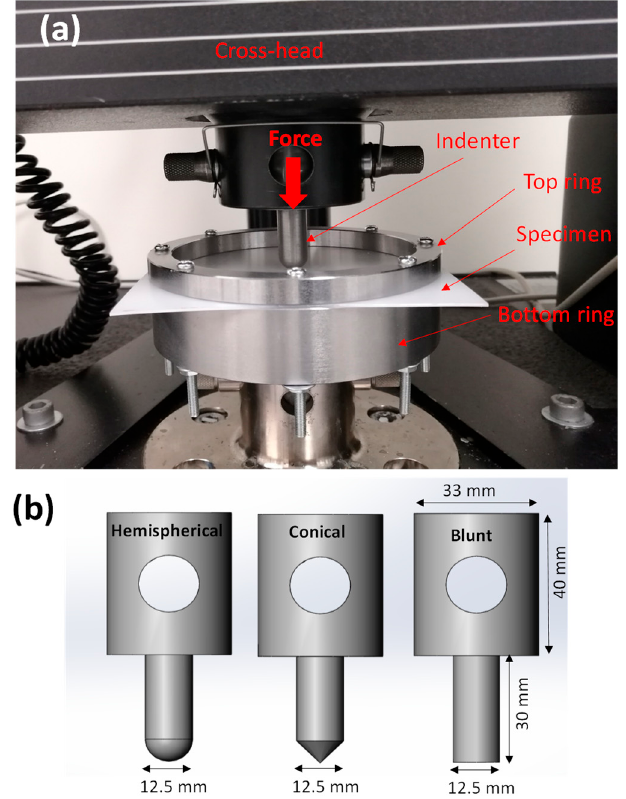
Figure 2. ( a ) Experimental setup for the quasi-static perforation tests and ( b ) the indenters’ geometric dimensions.